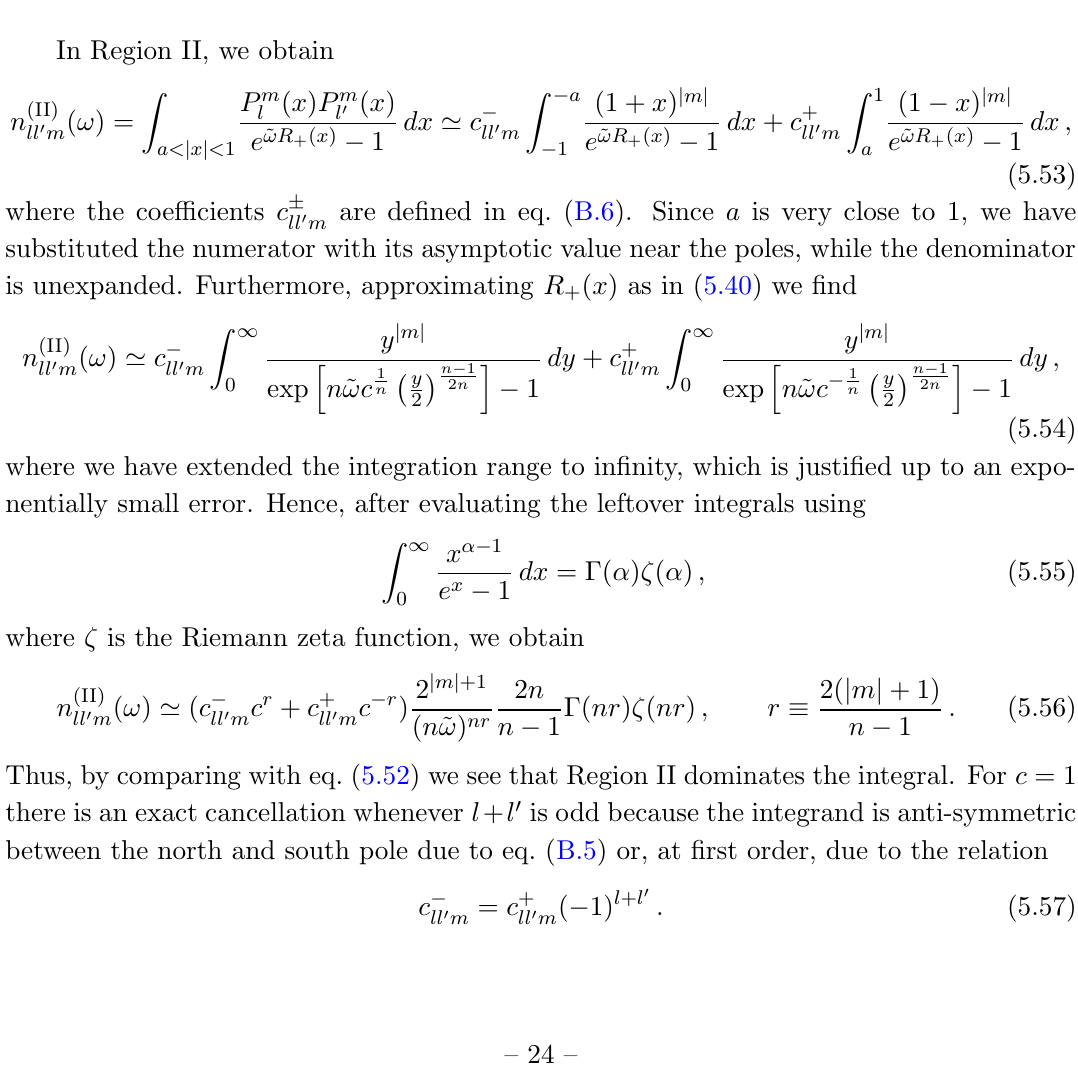
Figure 4 . A schematic representation of R + ( x ) for superrotations with c = 1. The shaded area highlights Region II, while the rest of the [ (cid:0) 1 ; 1] interval corresponds to Region I. The dashed lines illustrate the separation of scales considered in eq.